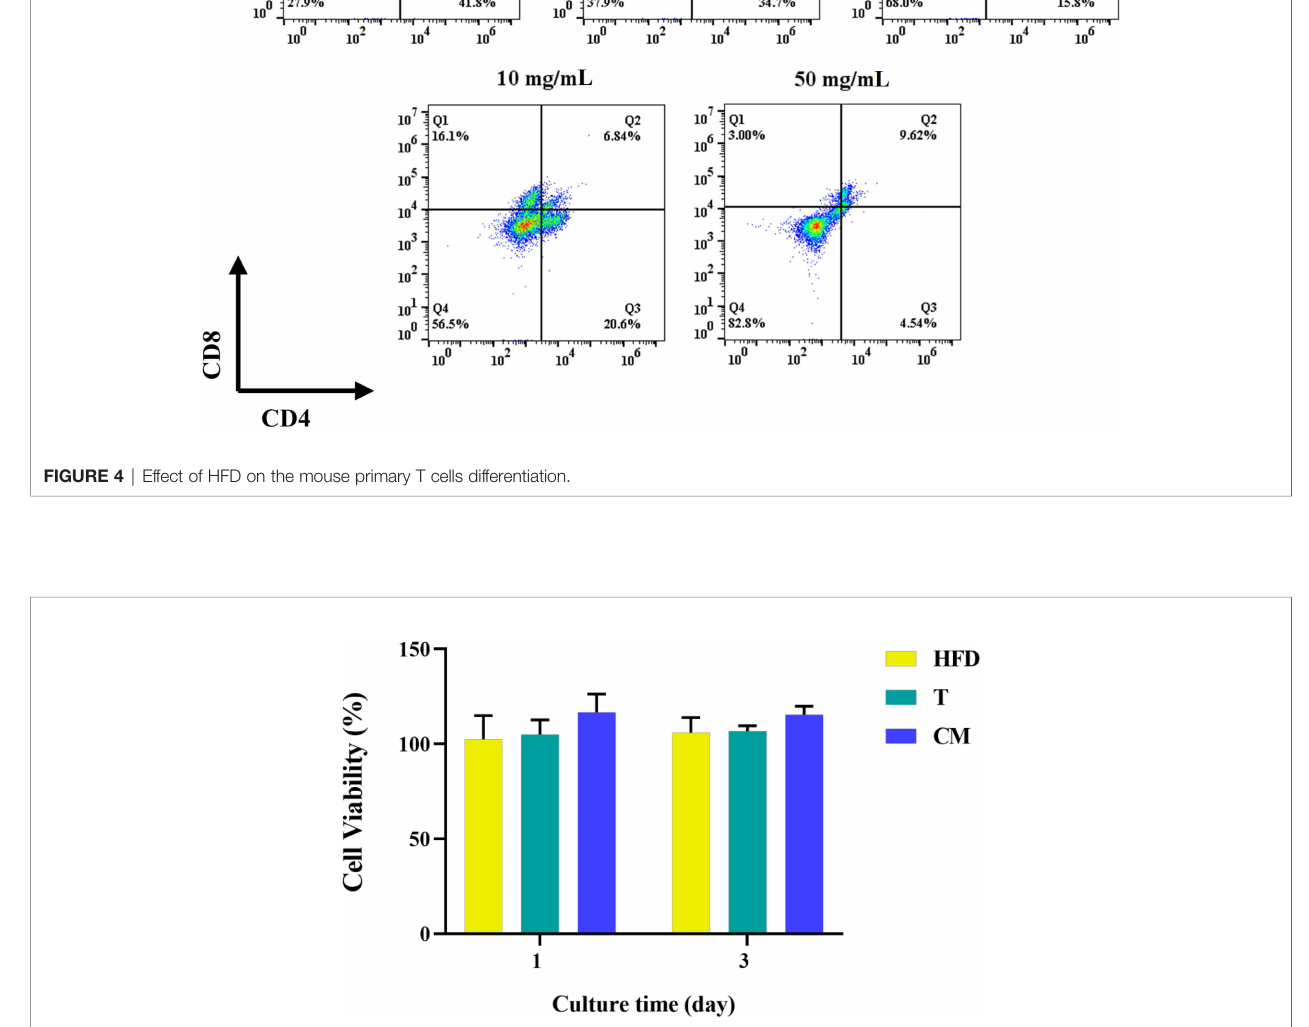
FIGURE 5 | MC3T3-E1 cell viability on various samples for 1 and 3 d. HFD: the group containing HFD; T: the group containing T cell supernatant; CM: supernatant from co-culture of T cells with HFD.